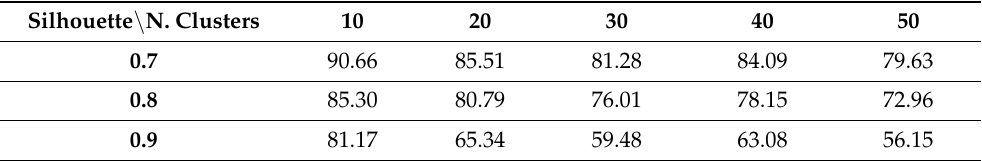
Table 45. Clustering performance in terms of silhouettes using the reduced dataset with SPQR. Silhouette \ N.